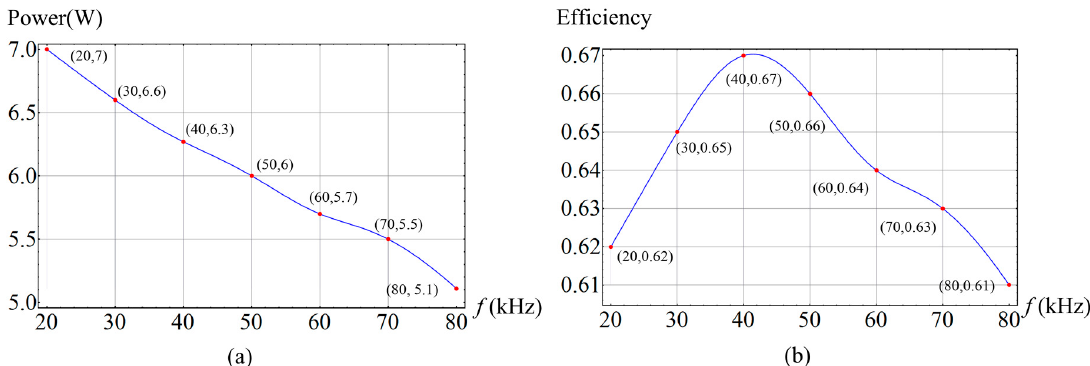
Figure 17. ( a ) Experiment results of power load related to frequency; ( b ) Experiment results of efficiency related to frequency.